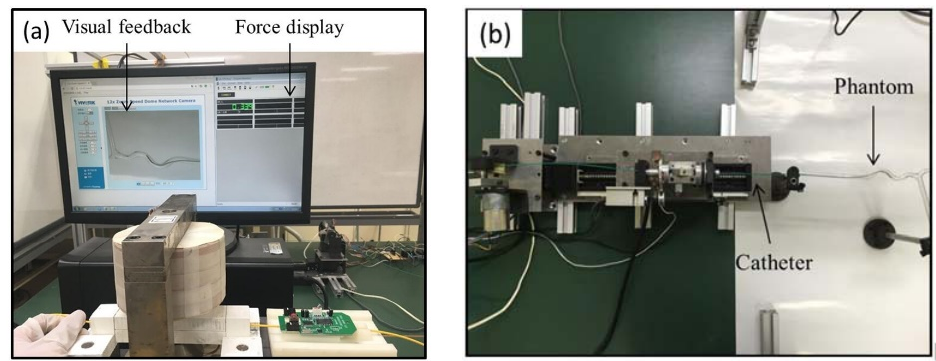
Figure15. Catheter operation process, ( a ) master system, ( b ) slave system. Figure 15. Catheter operation process, ( a ) master system, ( b ) slave